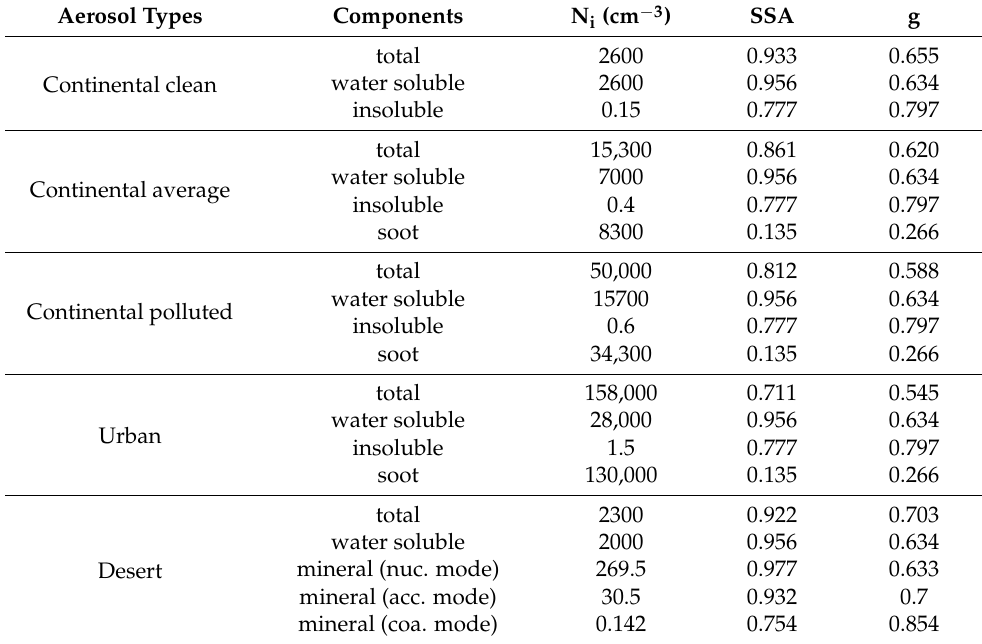
Table 1. Microphysical and optical properties of the aerosol models grouped by aerosol types and aerosol components, with OPAC values for the number densities (N i ) of aerosol components in particles cm − 3 , single scattering albedo ( SSA ) and asymmetry parameter ( g ) at a wavelength of 0.8 micrometers for 50% relative